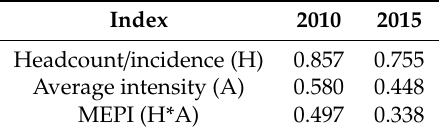
Table 3. Estimate for MEPI in Ghana between 2010 and 2015.